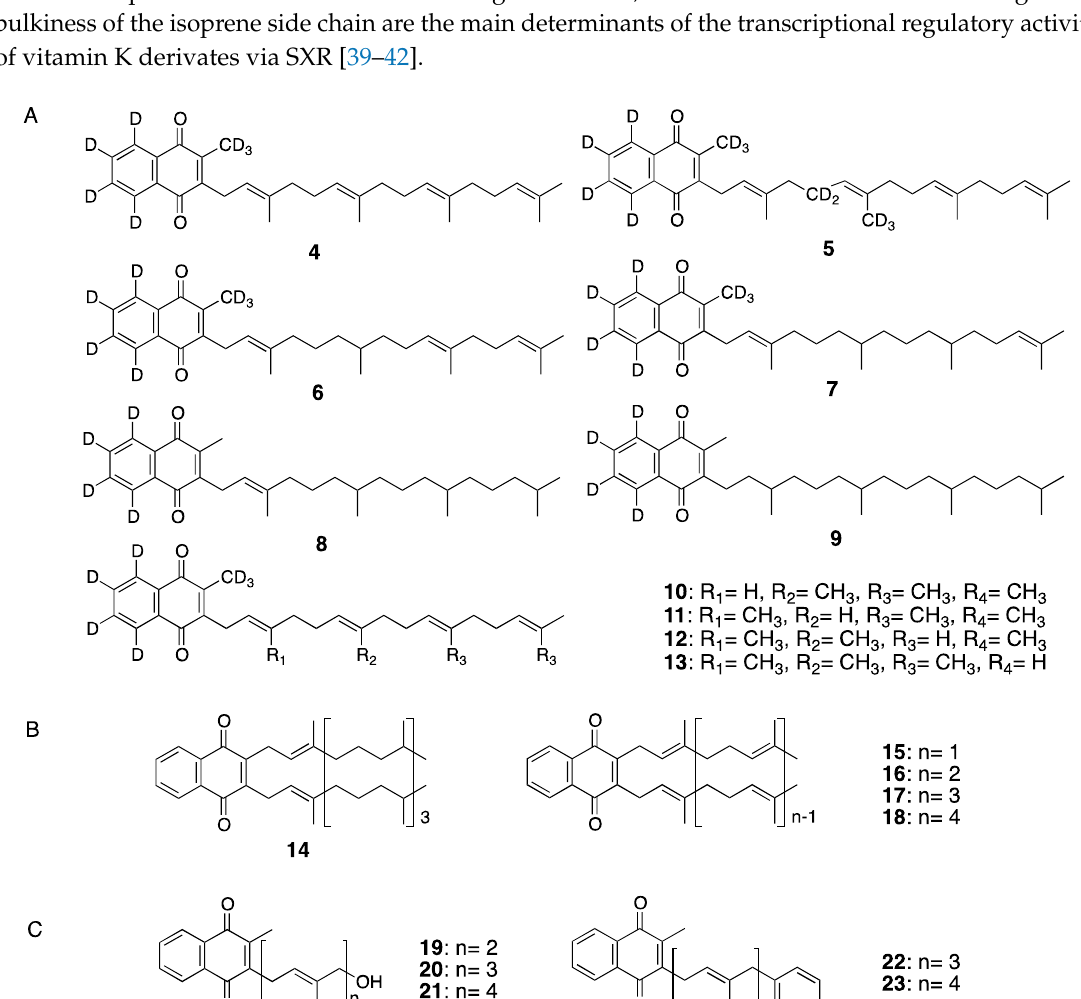
Figure 4. Vitamin K derivatives investigated for SXR-mediated transcriptional regulatory activity. ( A ) Deuterium labeled derivatives, ( B ) Double side chain derivatives, ( C ) Derivatives introduced a hydrophilic or a hydrophobic functional group.